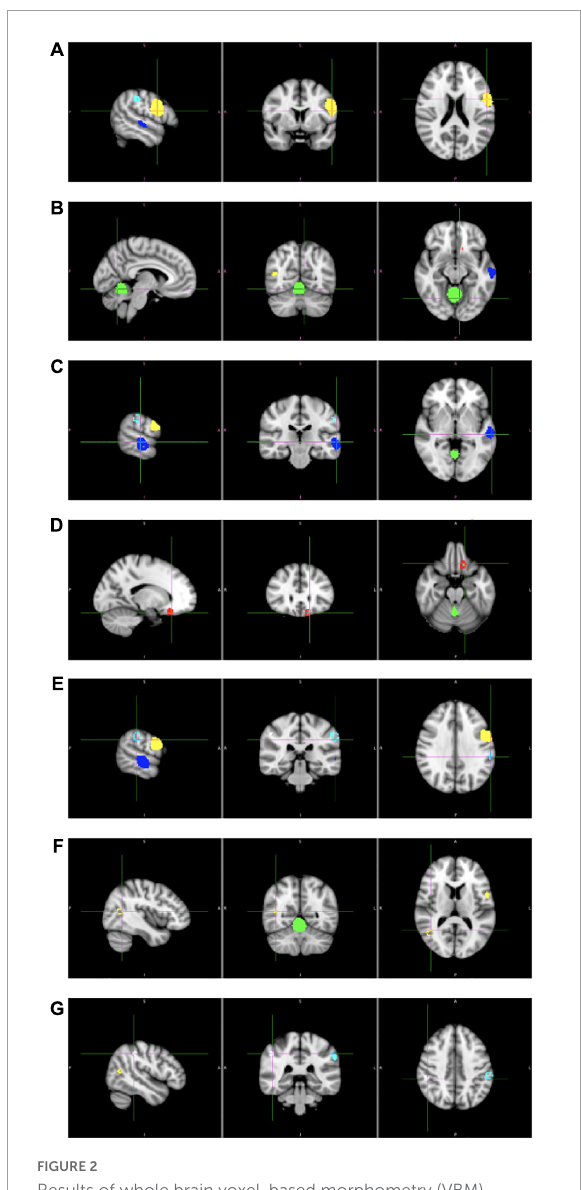
FIGURE2 Results of whole brain voxel-based morphometry (VBM) meta-analysis of childhood trauma in adolescents. Clusters (A–G) corresponds to the clusters in Table 1